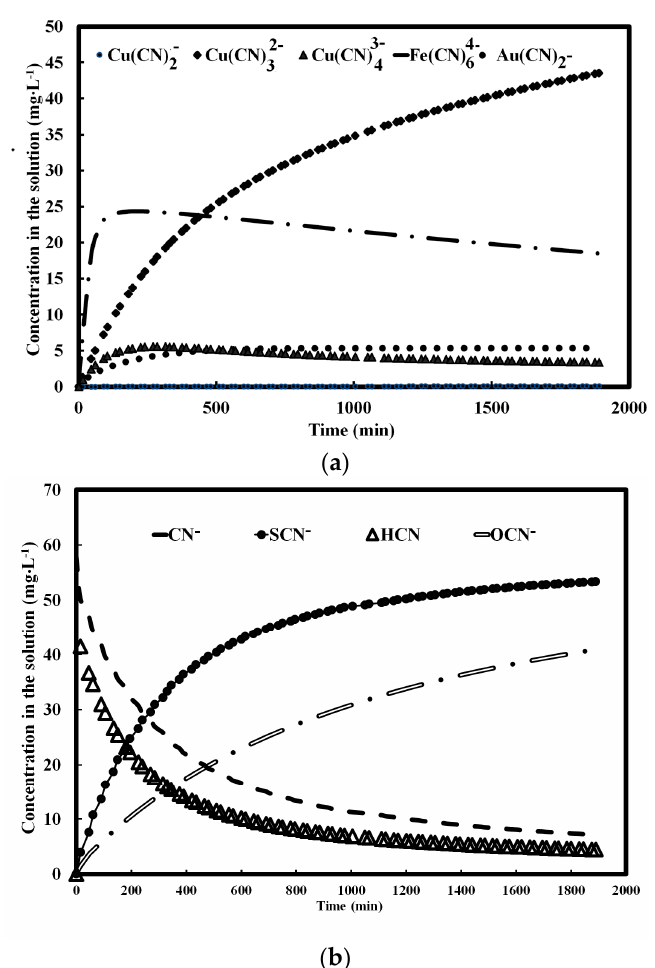
Figure 9. Concentration of the main cyanide complexes formed in solution for the gold + pyrite + chalcopyrite system at pH = 10.4; ( a ) Fe, Cu or Au (mg/L) as Fe(CN) 64 − , Cu(CN) 32 − , Cu(CN) 43 − , Cu(CN) 2 − and Au(CN) 2 − ; ( b ) CN (mg·L − 1 ) as HCN, CN − , CNO − and SCN − , 0.1 × CN − and 0.1 × SCN − concentration are plotted on the same scale.